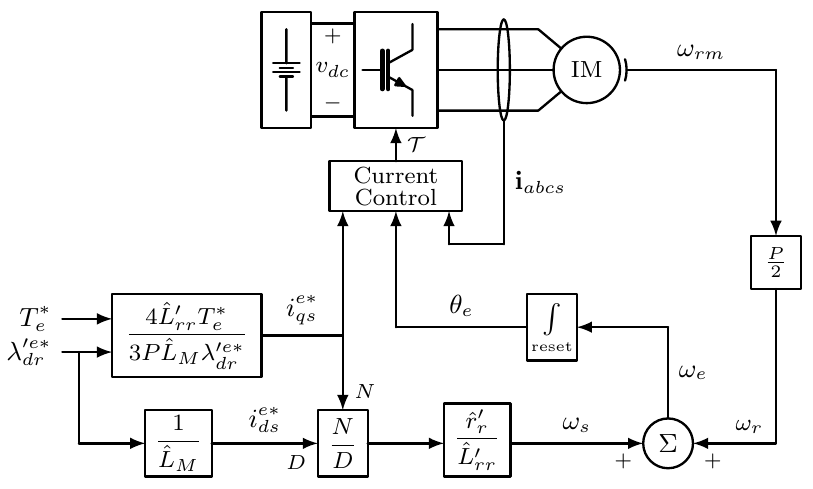
Figure 7. Indirect field-oriented control drive block